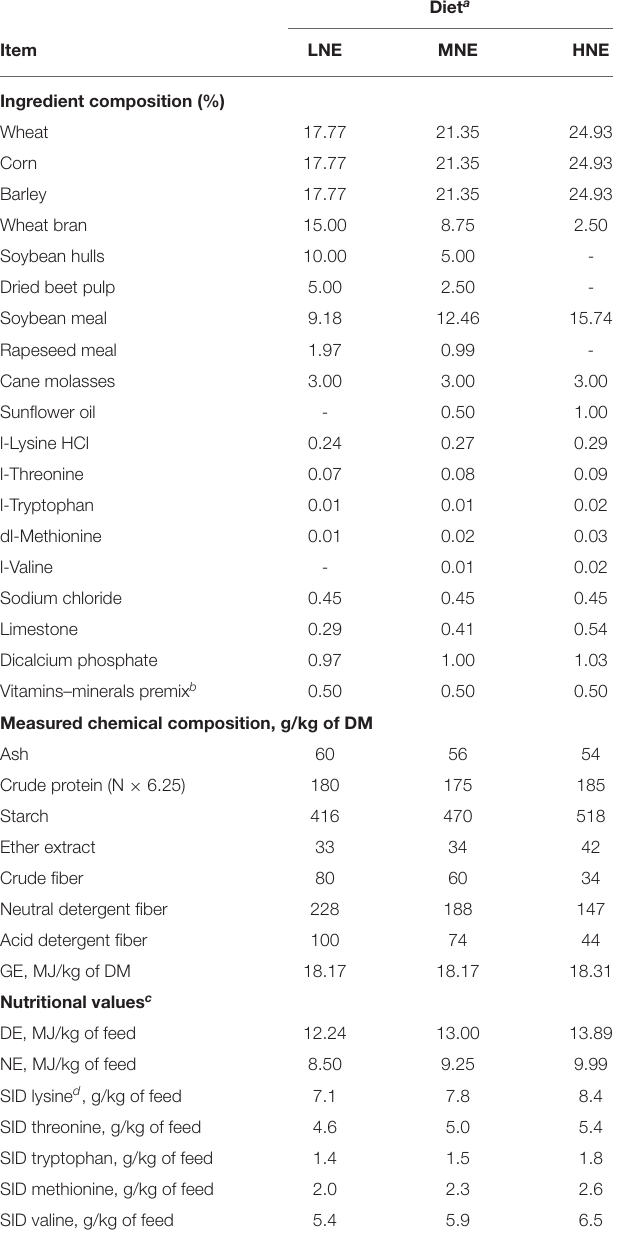
TABLE 1 | Ingredients and chemical composition of experimental diets fed to immunocastrated male